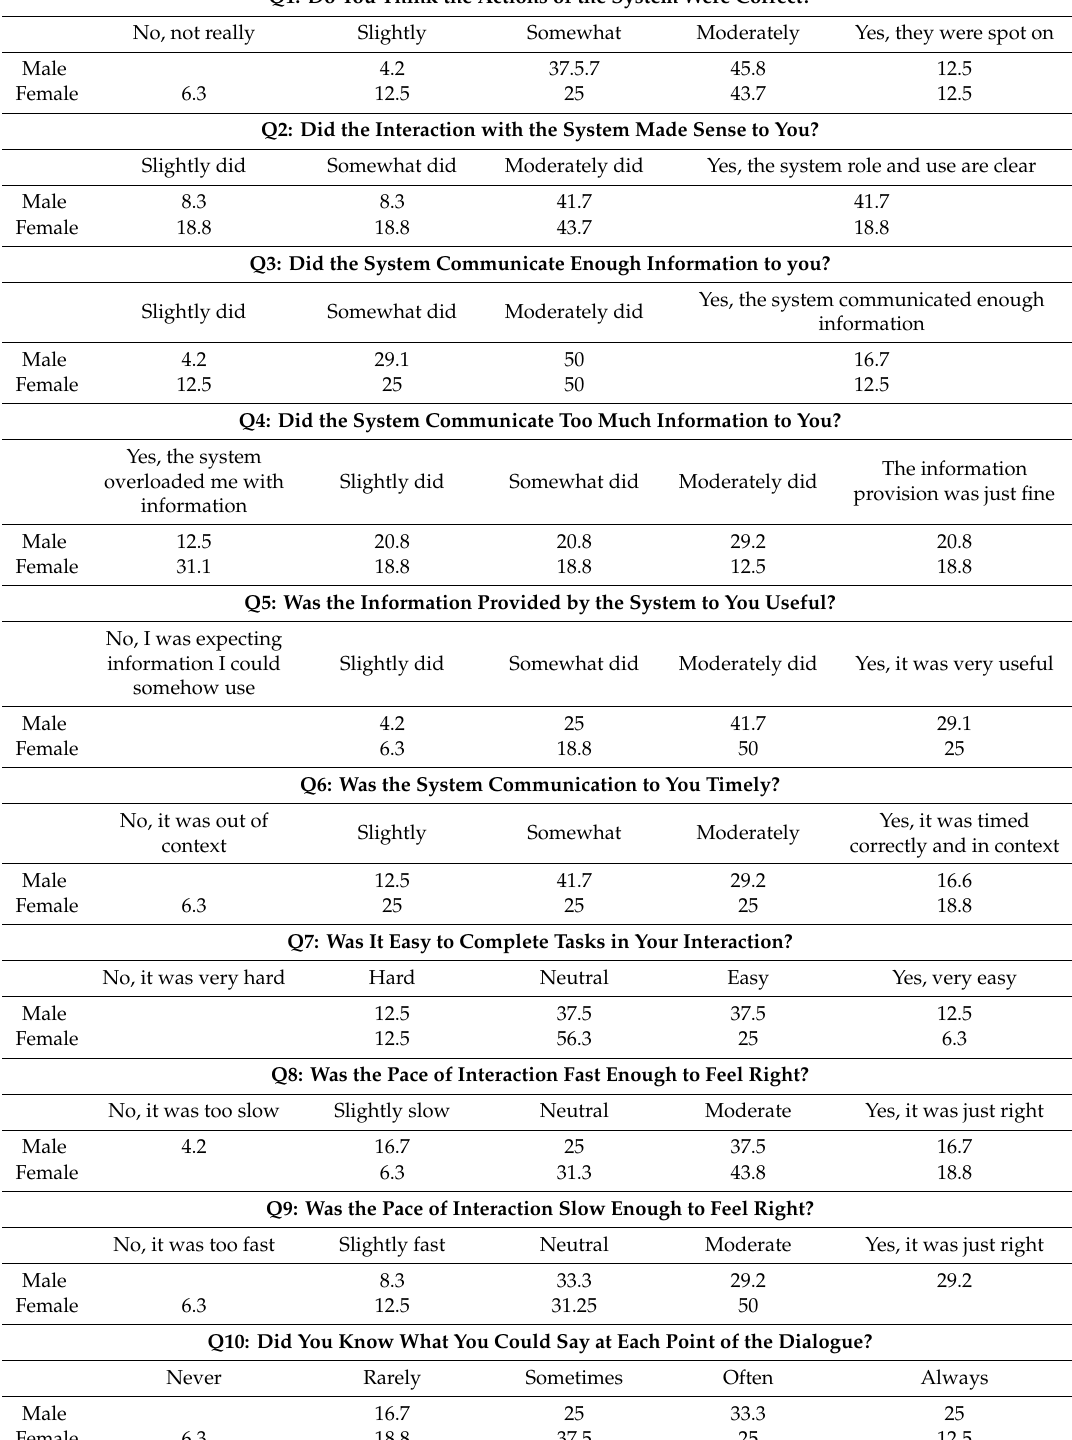
Table A1. Distribution (%) of users’ responses in usability evaluation postinteraction based on gender (N =